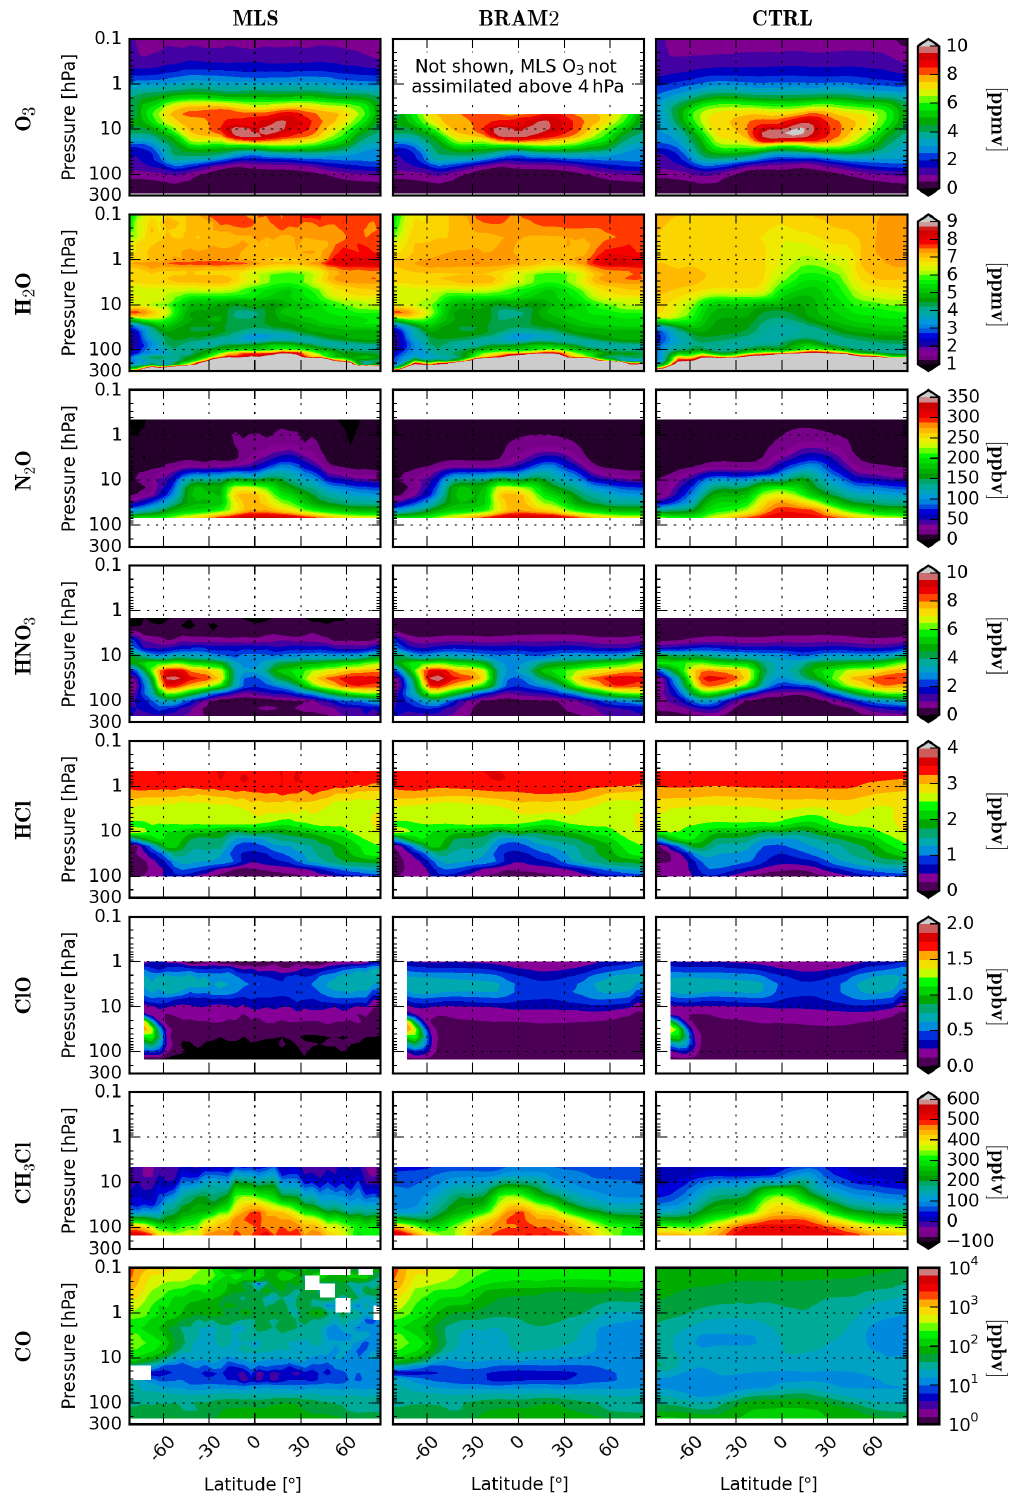
Figure 3. Daily zonal means of MLS observations (left column) on 1 September 2009, the corresponding ModAtObs values of BRAM2 (centre column) and CTRL (right column). From top to bottom: O 3 (ppmv), H 2 O (ppmv), N 2 O (ppbv), HNO 3 (ppbv), HCl (ppbv), ClO (ppbv, daytime values), CH 3 Cl (pptv) and CO (ppbv, note the log scale). Zonal means are calculated on the MLS pressure grid and binned on a 5 ◦ latitude grid. White squares in the MLS CO plot denote negative values. BRAM2 O 3 is not assimilated (and not shown) at an altitude above 4hPa; see text for